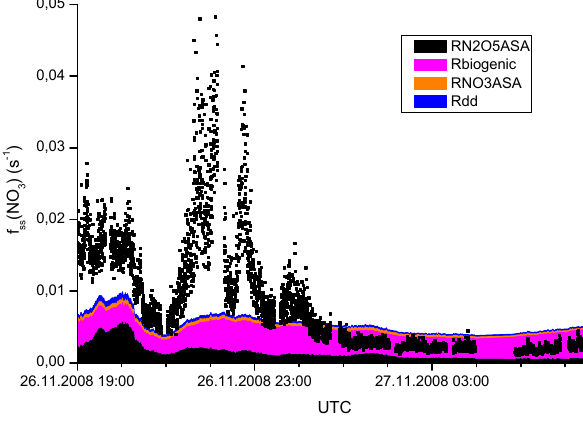
Fig. 11. Apportioned NO 3 loss rates on the night 26th–27th of November. The various contributions are: RN 2 O 5 ASA=uptake of N 2 O 5 to aerosol (using γ =0.04), Rbiogenic=reaction of NO 3 with isoprene, limonene and α -pinene, RNO 3 ASA=reaction of NO 3 on aerosol (using γ =0.1), Rdd=summed dry deposition of N 2 O 5 and NO 3 . The black datapoints are measurements of loss frequency of NO 3